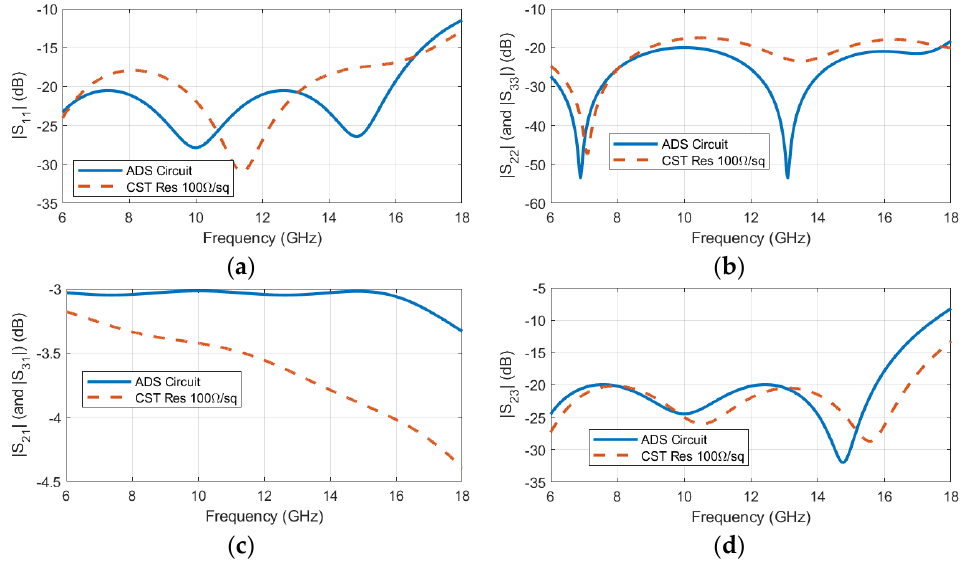
Figure 9. S-parameters results and comparison between the circuit and the full-wave model. Specifically, the return loss at Port 1 and at Port 2 (and 3) are shown in ( a , b ), whereas the insertion loss and coupling factor are given in ( c , d ), respectively.